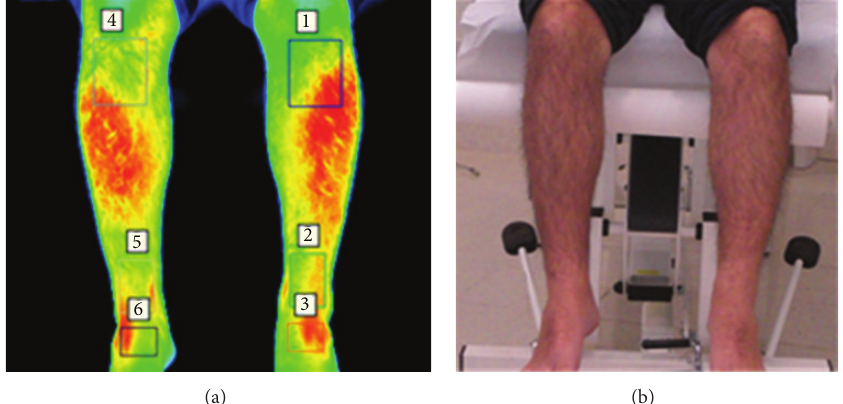
Figure 3: Participants were asked to hang their legs over the edge of the couch, with their feet held momentarily in slight plantarflexion, while a thermal image (a) and a visual image (b) were acquired. Measurement regions were then annotated on the thermal image (a) for further